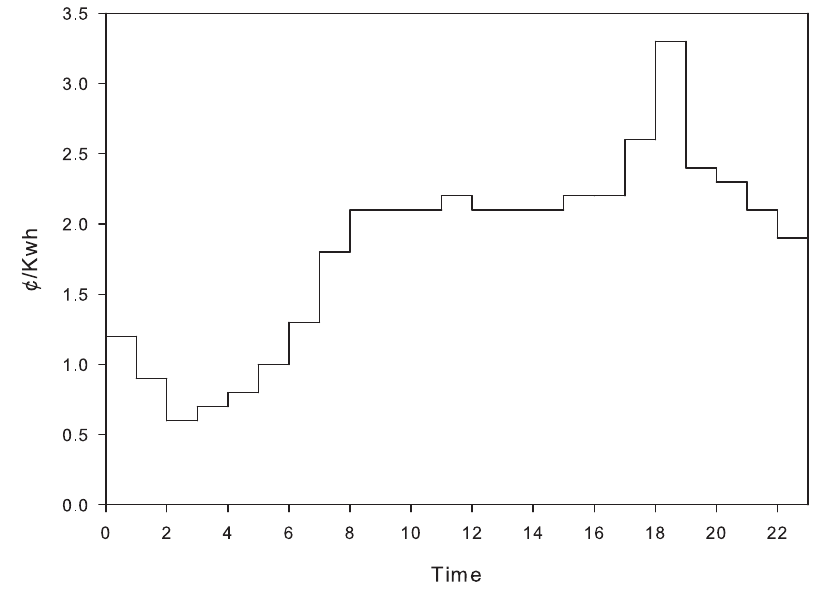
Figure 4. Hourly pricing program used for evaluating the proposed model. The data are taken from ComEd